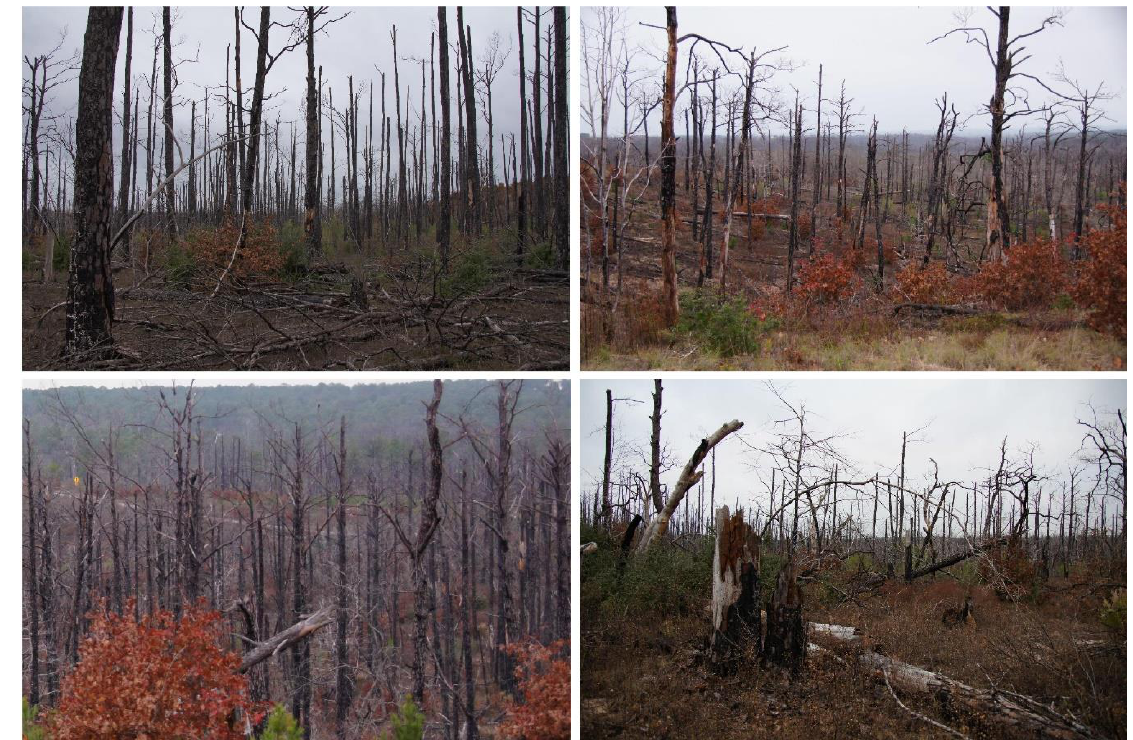
Figure 1. Slow vegetation response at post high-severity fire areas in Bastrop in 2014 (photos by Tomasz E. Koralewski).